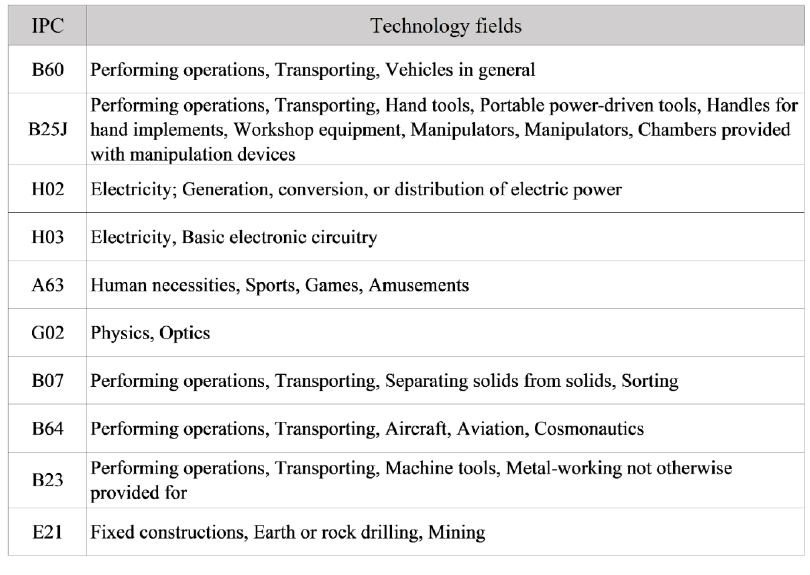
Fig. 15 Definitions of IPC numbers in other